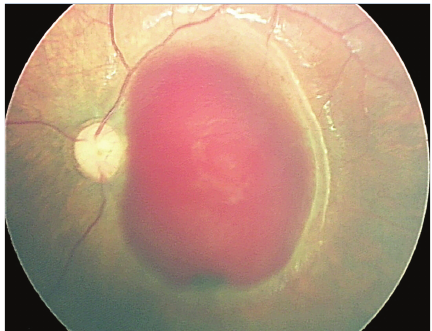
Figure 1: Retinography made by RetCam of the posterior pole of the left eye of an abused child. Note the extensive subinternal limiting membrane hemorrhage.